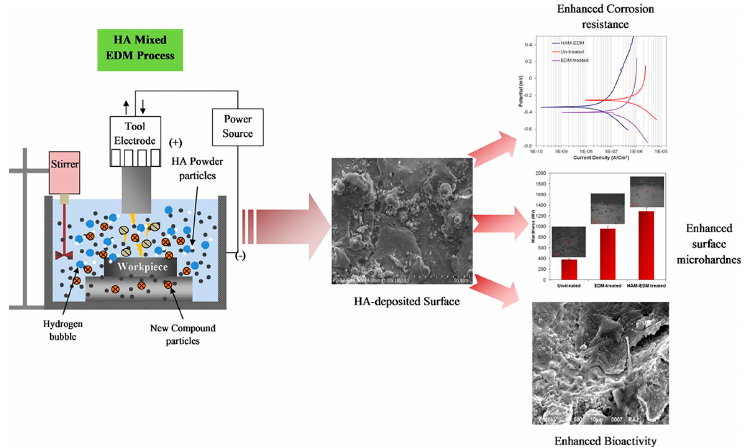
Figure 4. The enhancement of corrosion resistance, hardness, and bioactivity on HA-deposited sur- face (surface modification of β -phase Ti implant by hydroaxyapatite mixed electric discharge ma- chining to enhance the corrosion resistance and in-vitro bioactivity). Reproduced with permission from [93], copyright Elsevier, 2017.